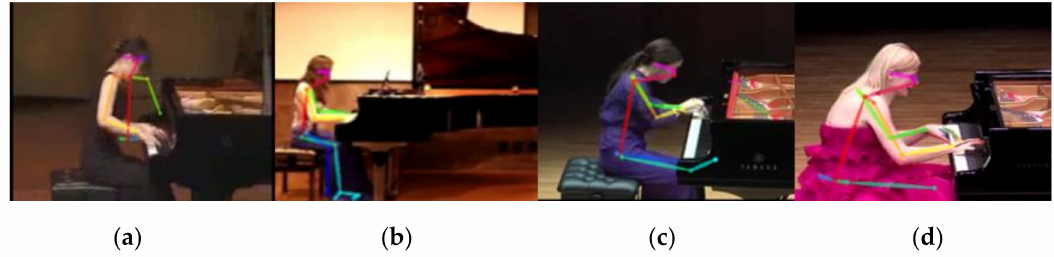
Figure 1. Limitations of existing methods. The posture classification accuracy may degrade when the skeletal recognition rate decreases due to ( a ) deteriorating video quality; ( b ) hand covering the piano; ( c ) rapid hand movement; ( d ) hand